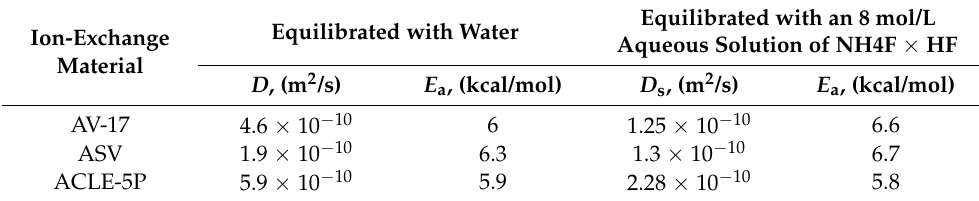
Table 9. Average water self-diffusion coefficients D at 293 K and self-diffusion activation energies in the anion-exchange resin AV-17 and in the membranes ASV and ACLE-5P in the F − form equilibrated with water and an 8 mol/L aqueous solution of NH 4 F × HF.